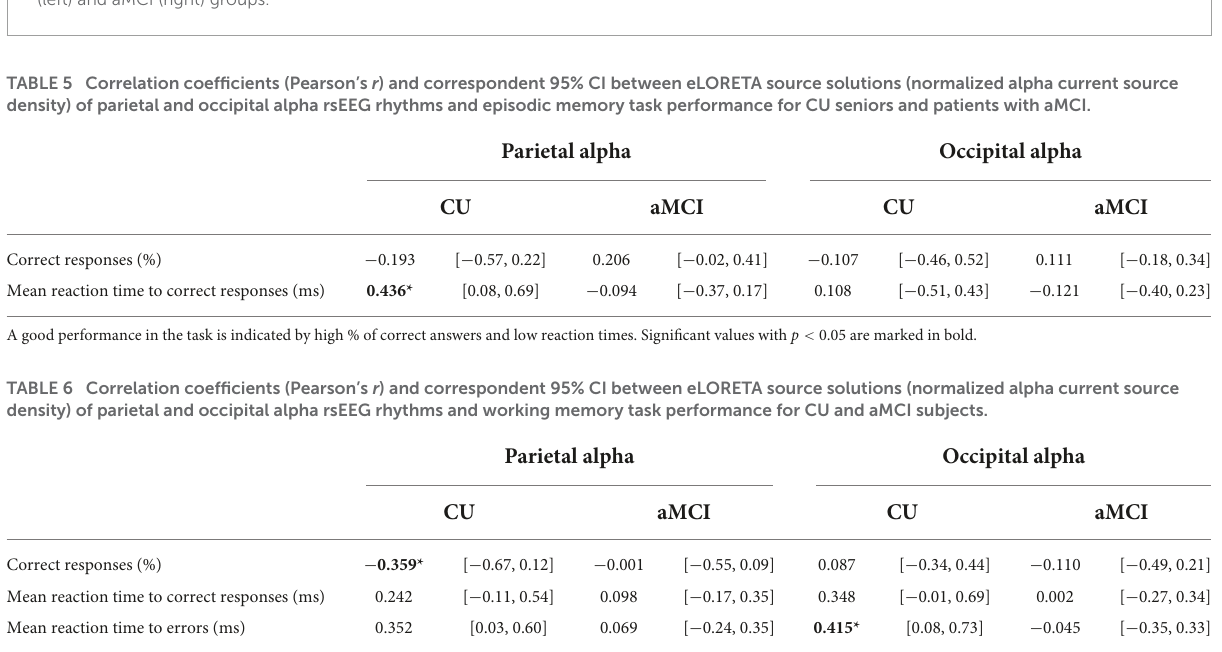
FIGURE1 (A) Mean values and standard errors (denoted by the vertical bars) for the eLORETA source solutions (normalized alpha current source density) of rsEEG occipital and parietal alpha for CU (gray line) and aMCI (black line). (B) Topographic distribution of alpha activity at 9 Hz (closest to IAFp), and power spectra for each electrode for CU (top) and aMCI (bottom) groups, together with the mean power spectra between 0.5 and 45 Hz for both groups (CU in blue and aMCI in black). (C) Individual values of the regional normalized eLORETA source solutions (normalized alpha current source density) of rsEEG alpha in the parietal (green dots and area) and occipital (brown dots and area) regions of interest for CU (left) and aMCI (right) groups.